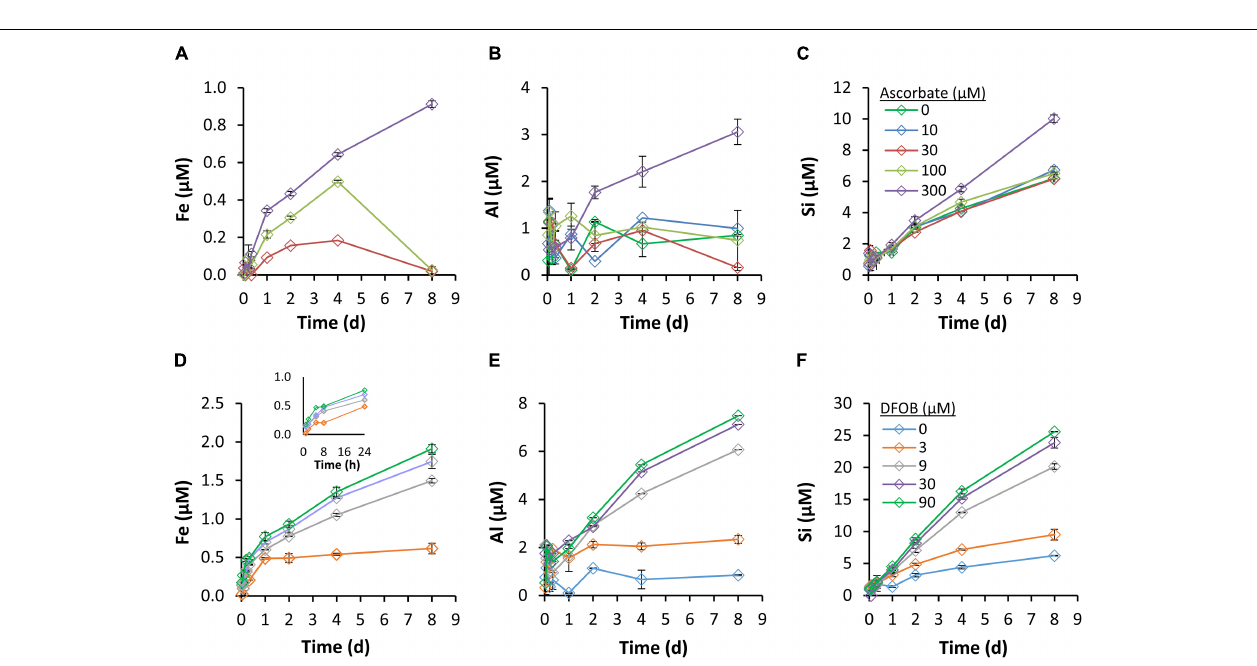
FIGURE 2 | SEM-EDS analysis of the small particle population. The small particles were observed in the form of particle aggregates (A) or adsorbed to large particles, such as the presented calcite particle (B) . A typical EDS spectrum obtained from the particle aggregates, with the average chemical composition of six analyzed aggregates, is presented in C .